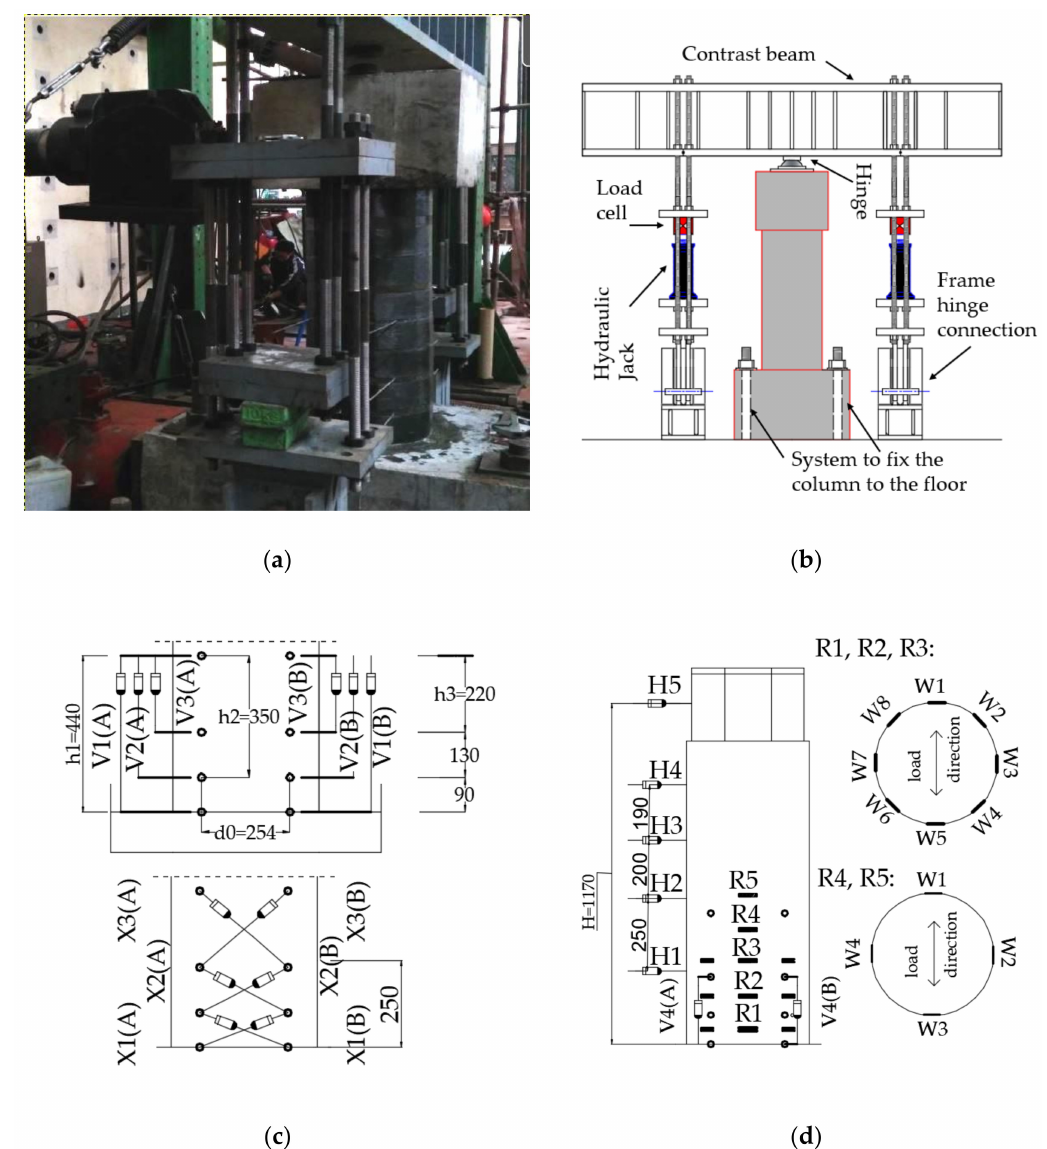
Figure 10. Cyclic test apparatus: ( a ) Photo of the Fuzhou University laboratory, ( b ) design scheme, and ( c ) applied instrument to measure at the column base: Vertical (V) and diagonal (X) deformations; ( d ) horizontal (H) and concrete jacket strains